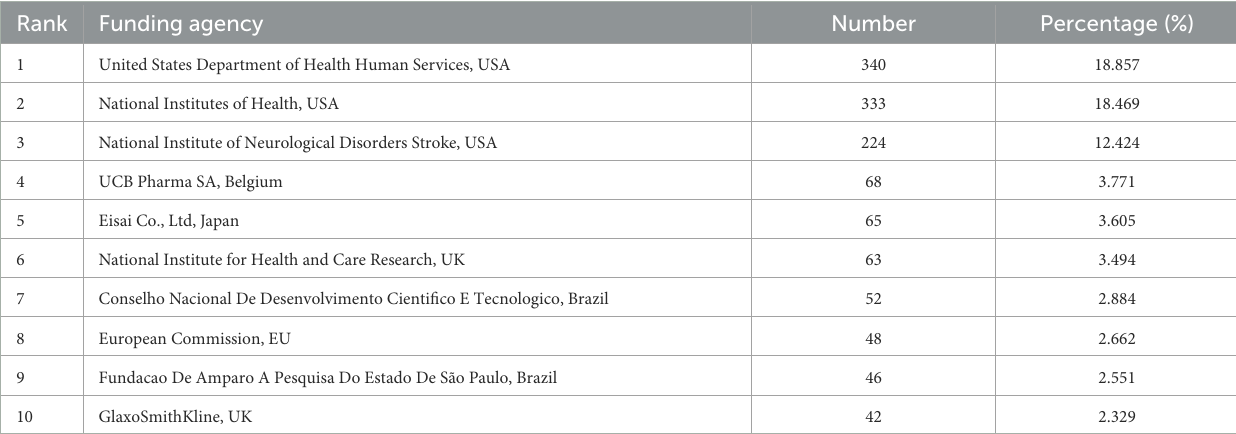
TABLE 3 Top 10 funding agencies for SUDEP research.